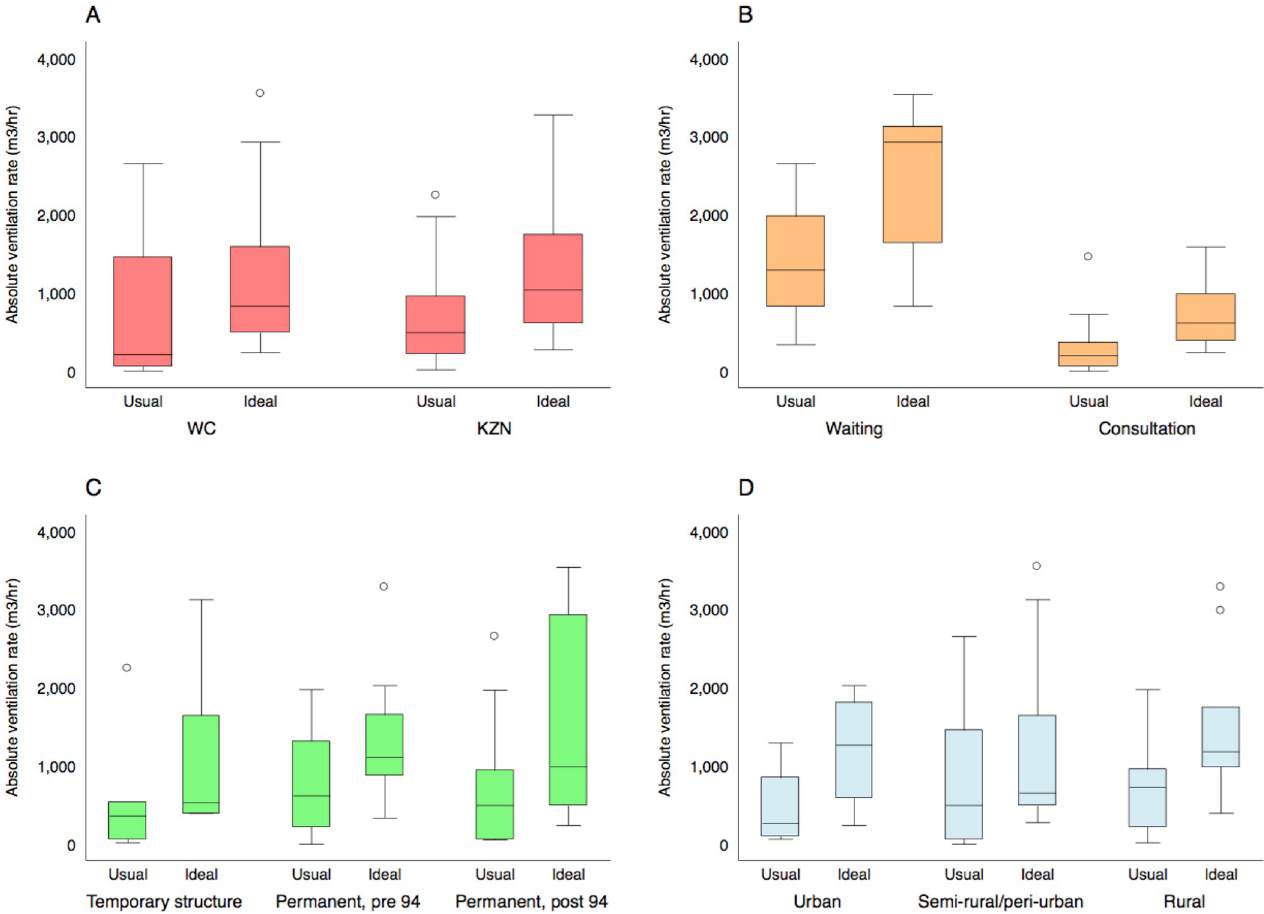
Fig 5. Box and whisker plots describing the distribution of the absolute ventilation rate in the 26 clinical spaces where we conducted tracer gas release experiments. Ventilation rates are described under usual conditions and with all doors and windows fully open. Results are disaggregated by province (Fig 5A), room type (Fig 5B), the age of the building (Fig 5C), and clinic location (Fig 5D). Here, the boxes mark the 25 th percentile, the 50 th percentile (median) and the 75 th percentile, with the whiskers marking the upper and lower adjacent